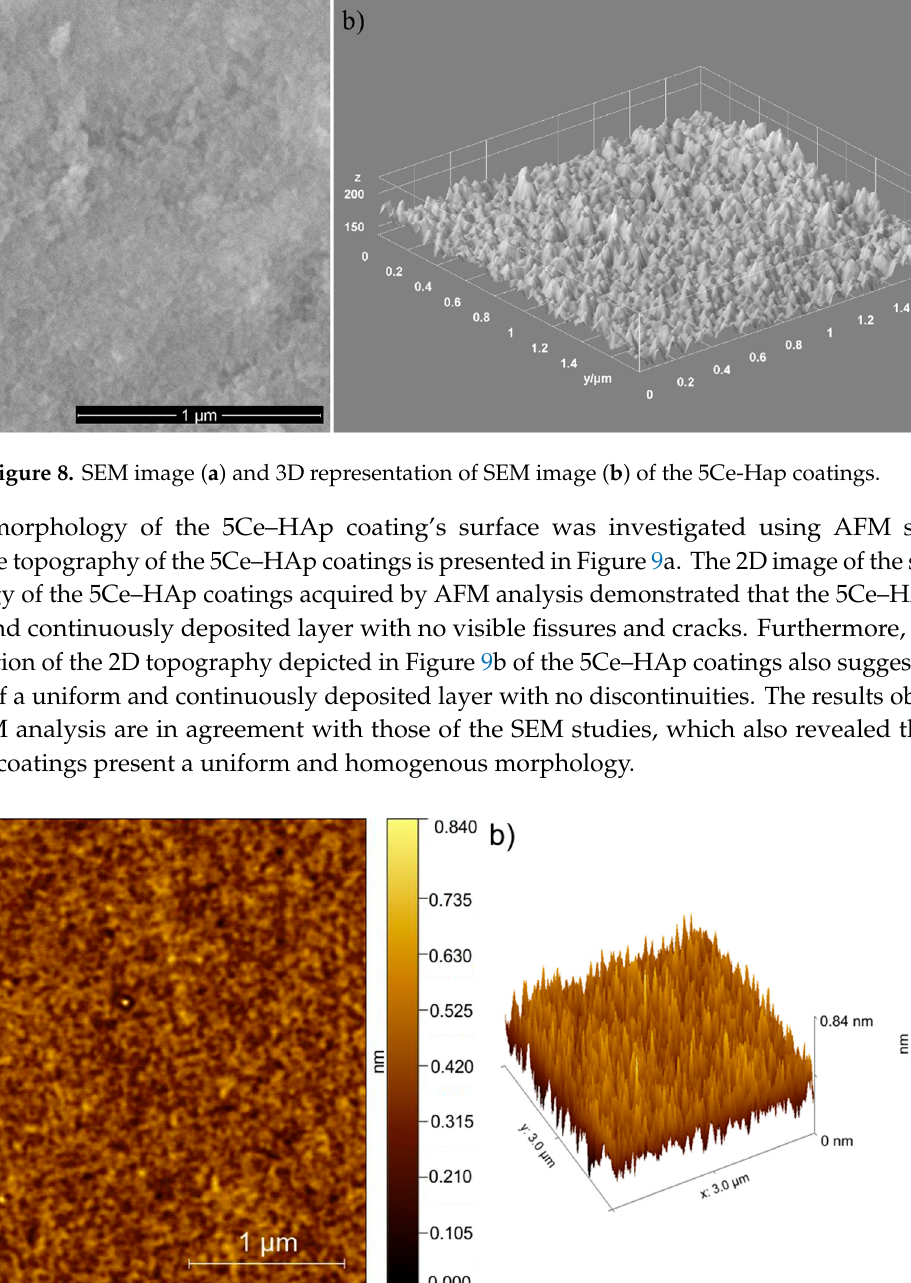
Figure 7. SEM surface morphology images of 5Ce-HAp ( a ). The element mapping of the prepared 5Ce-HAp coating ( b – e ). The overlap of the constituent elements ( f ).